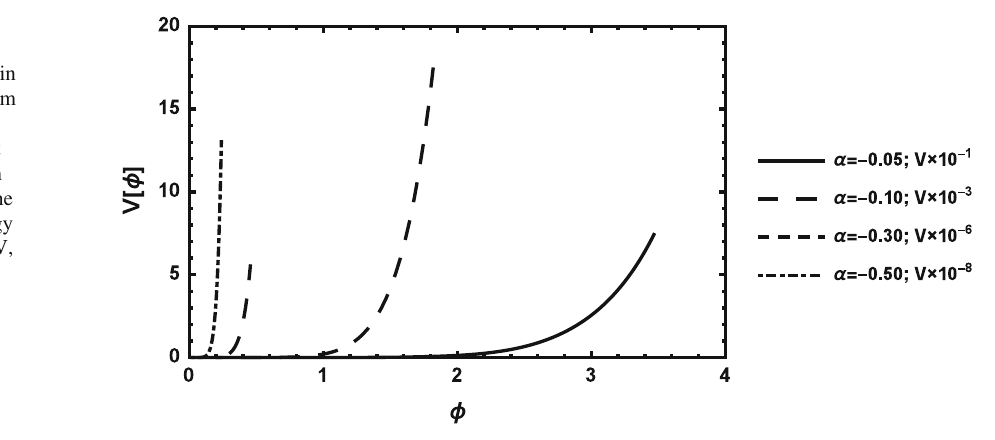
Fig. 6 The behavior of the scalar field potential V (φ) versus the inflation scalar field in the chameleon field driven warm inflation model in the strong dissipative regime for different values of ( n ,α) , obtained from Fig. 5. The figure shows that the inflation could start from energy scales of the order of 10 15